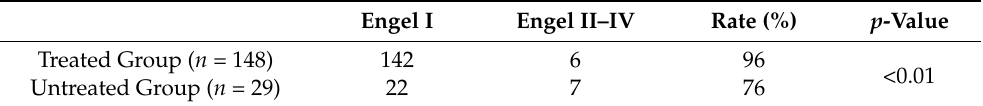
Table 4. The Engle class of epilepsy patients after surgery at the long-term follow-up. Engel I Engel II–IV Rate (%) p -Value Treated Group ( n = 148) 142